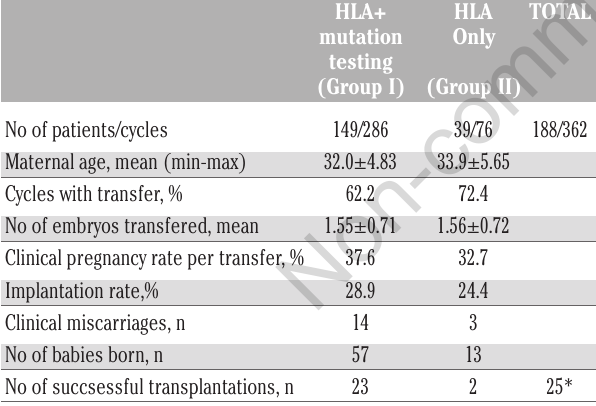
Table 2. Overall clinical results of HLA typing.